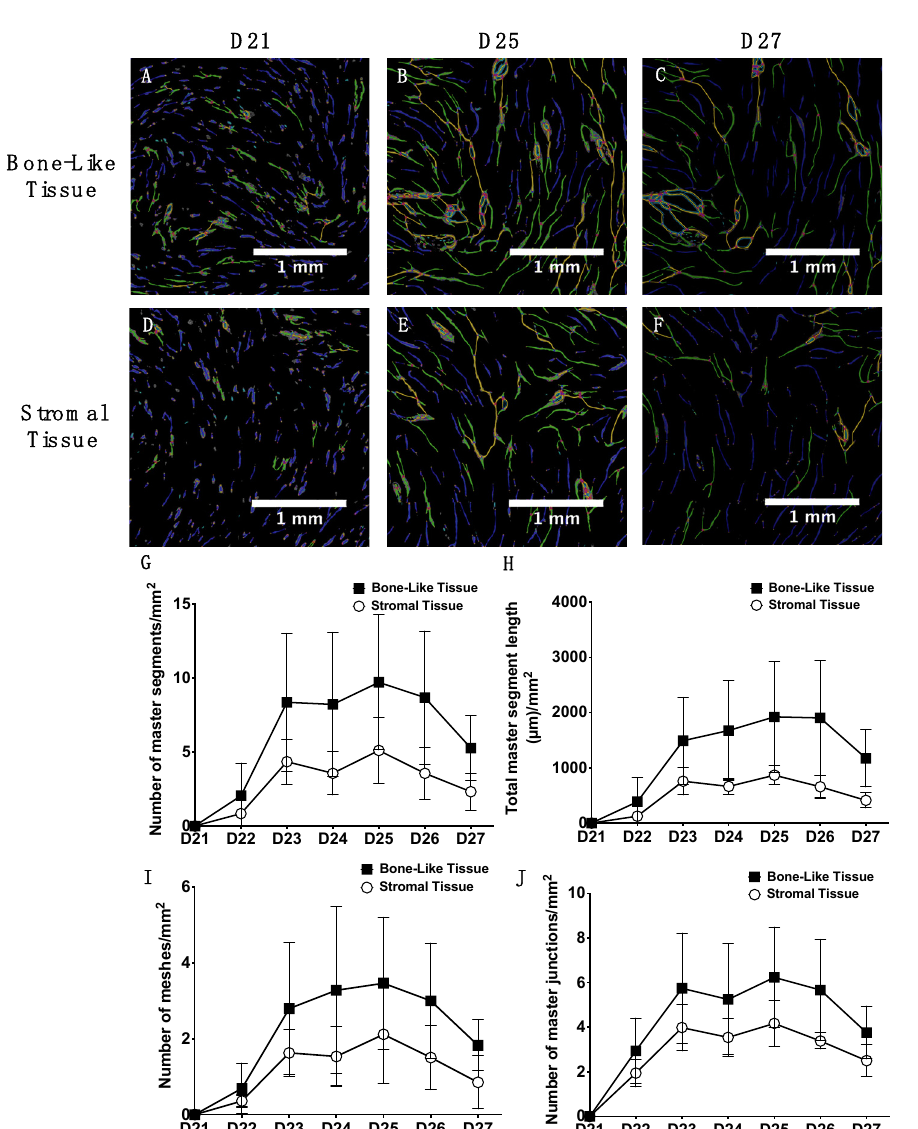
Figure 2. Kinetics of the capillary network formation on individual cell sheets over six days of maturation, prior to cell sheet stacking into tissues. Large regions of interest of the prevascularized cell sheets were imaged for GFP-positive structures for six consecutive days (D21 through D27) after endothelial cell seeding (D21) ( A – F ). Pictures were then analyzed using the Angiogenesis Analyzer plug-in of ImageJ ® software. Scale bars, 1 mm. Temporal analysis of in vitro capillary network formation revealed more numerous (but non-significant): numbers of master segments per mm 2 (yellow lines in ( A – F )) ( G ), length of the master segments per mm 2 ( H ), number of meshes per mm 2 (cyan blue meshes in ( A – F )) ( I ), and master junctions (pink dots in ( A – F )) connecting two master segments per mm 2 ( J ) within cell sheets induced towards osteogenesis compared to stromal cell sheets. Two-way ANOVA with a Bonferroni’s multiple comparisons test (n = 3 tissues/condition per time point).